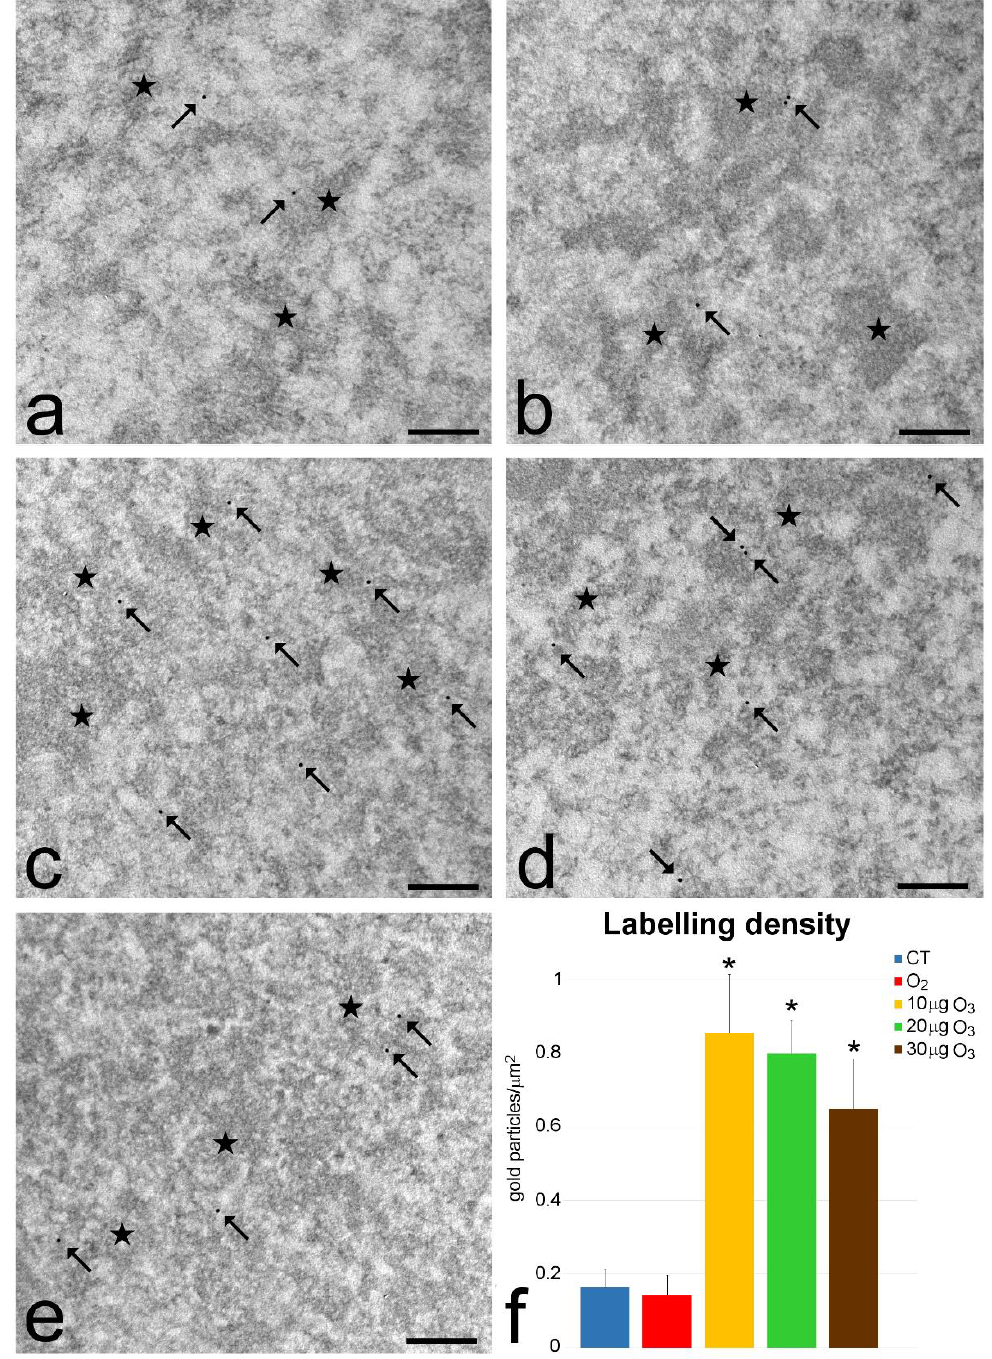
Figure 4. ( a – e ) TEM micrographs of nuclear details from Jurkat cells after 24 h from treatment: control ( a ), O 2 ( b ), 10 µg O 3 ( c ), 20 µg O 3 ( d ), 30 µg O 3 ( e ). Immunogold labelling for Nrf2 is located at the periphery of heterochromatin clumps (stars). Bars: 200 nm. ( f ) Diagrams show the mean value ± SD of anti-Nrf2 labeling; asterisks (*) indicate significant difference ( p < 0.001) with control (CT).